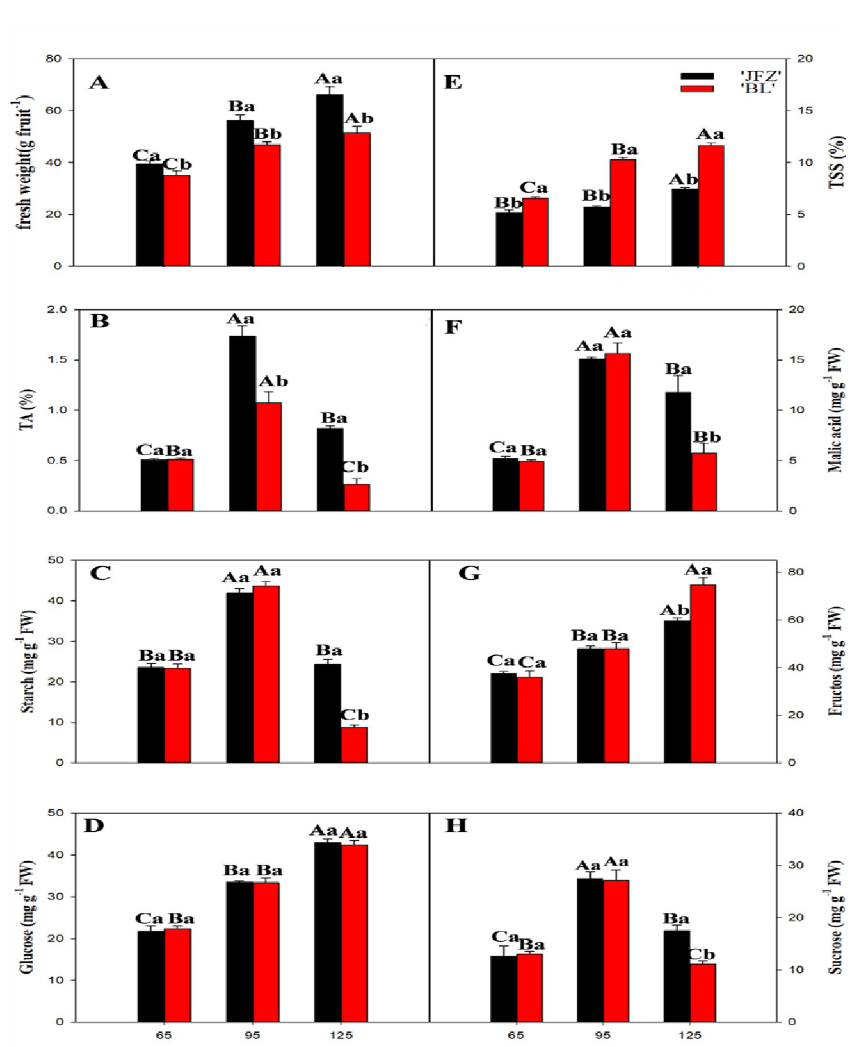
Differences among the samples were analyzed by two (cultivars) × three (sampling dates) ANOVA. The different lowercase letters indicate significant differences between the two cultivars at the same time point at p < 0.05. The different capital letters indicate significant differences among different time points for the same cultivar at p < 0.05. Each point represents mean ± SD (n =